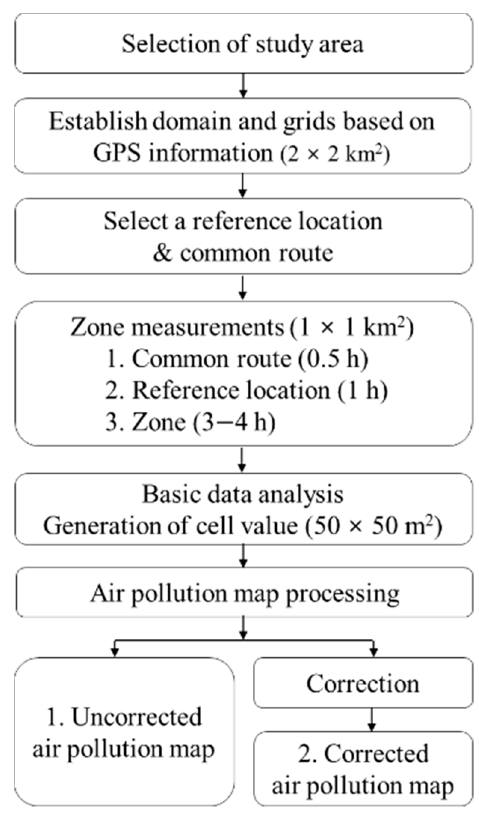
Figure 1. Flow chart of the methodological framework for the 2-D gridded air pollution map.